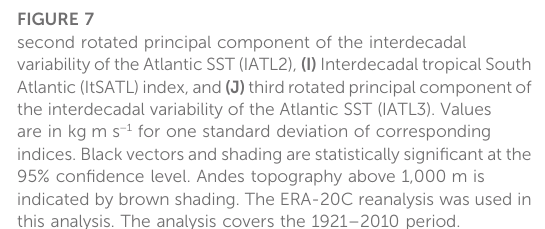
FIGURE 7 second rotated principal component of the interdecadal variabilityof theAtlanticSST (IATL2), (I) InterdecadaltropicalSouth Atlantic(ItSATL)index,and (J) thirdrotatedprincipalcomponentof the interdecadal variability of the Atlantic SST (IATL3). Values are in kg m s − 1 for one standard deviation of corresponding indices. Black vectors and shading are statistically signi fi cant at the 95% con fi dence level. Andes topography above 1,000 m is indicated by brown shading. The ERA-20C reanalysis was used in this analysis. The analysis covers the 1921 – 2010